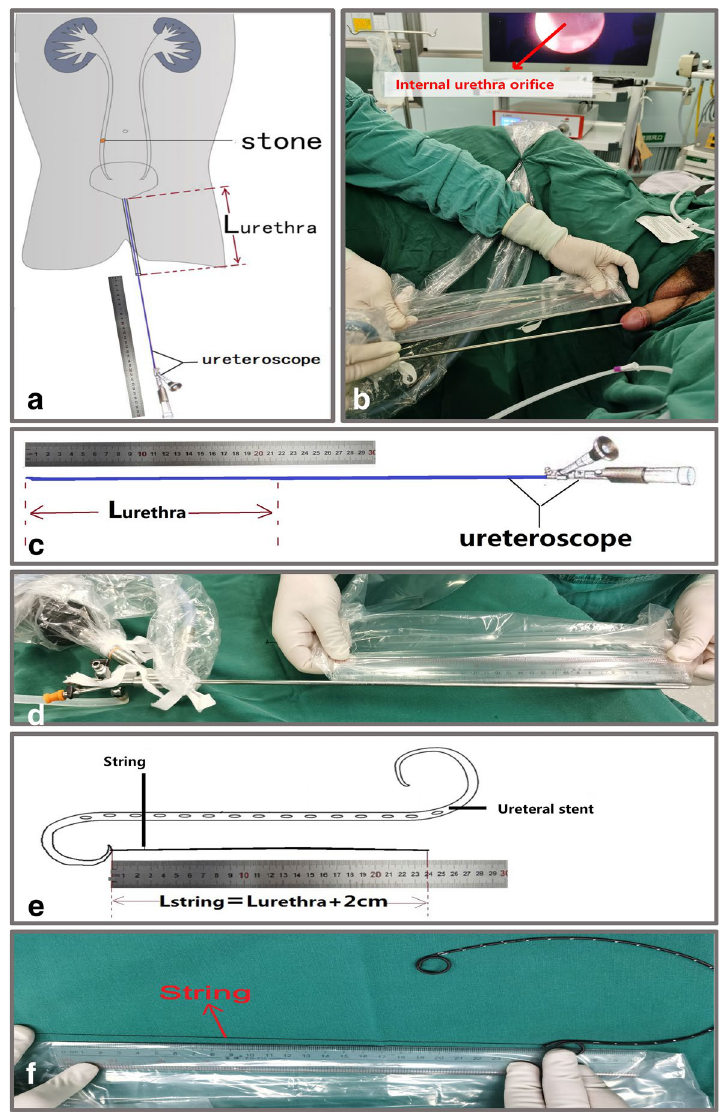
Figure 1. Diagrammatic sketch/surgery photo of marking Lurethra ( a , b ), measuring Lurethra ( c , d ) and determining Lstring ( e , f